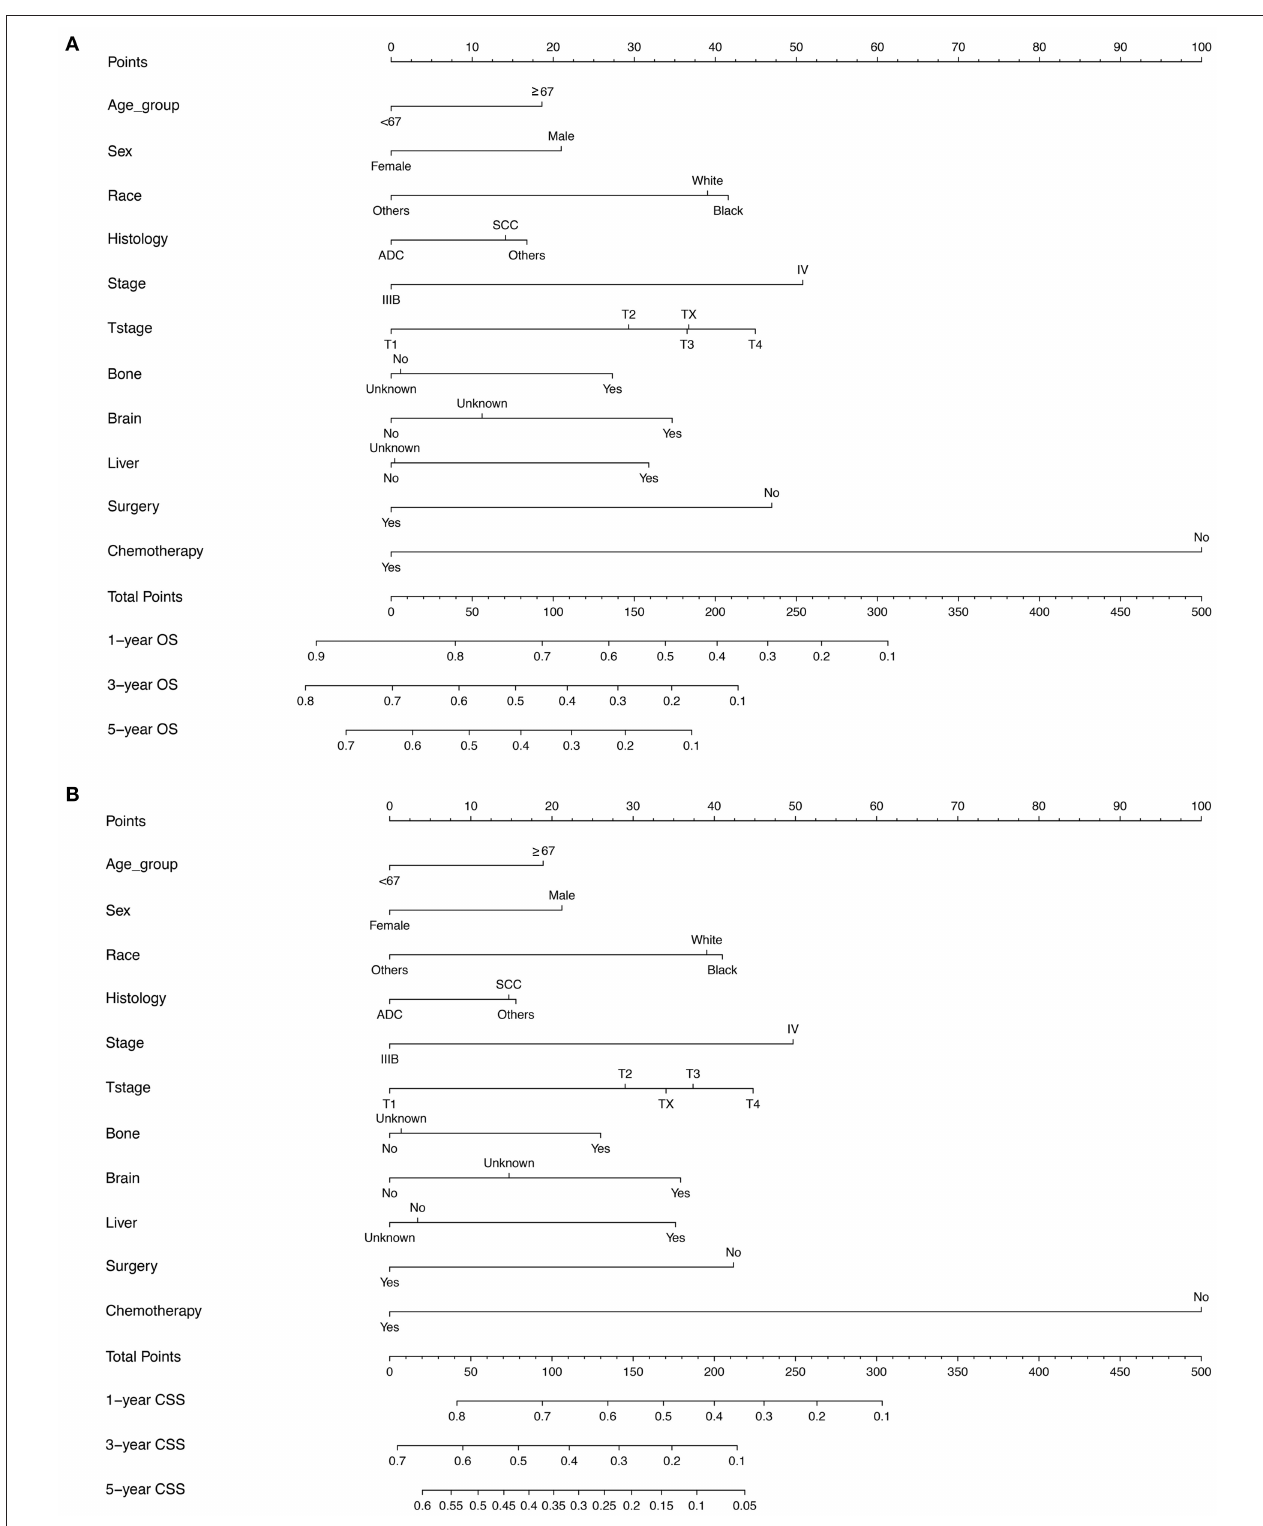
FIGURE 3 | The nomogram models for predicting (A) OS (B) lung CSS in patients with N3-NSCLC. ADC, adenocarcinoma; SCC, squamous cell carcinoma.